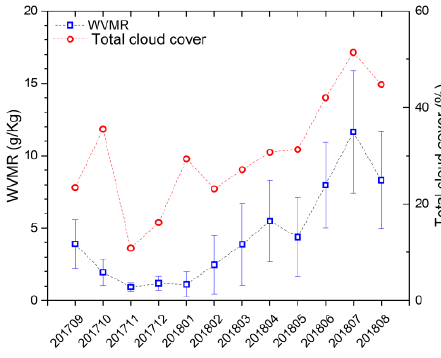
Figure 5 water vapor mixing ratio (WVMR) and total cloud